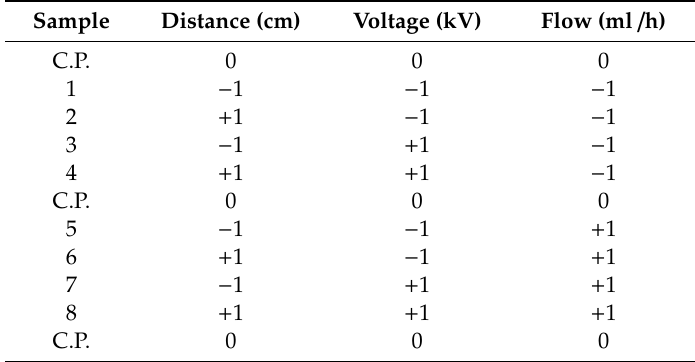
Table 1. Experimental points of the full factorial